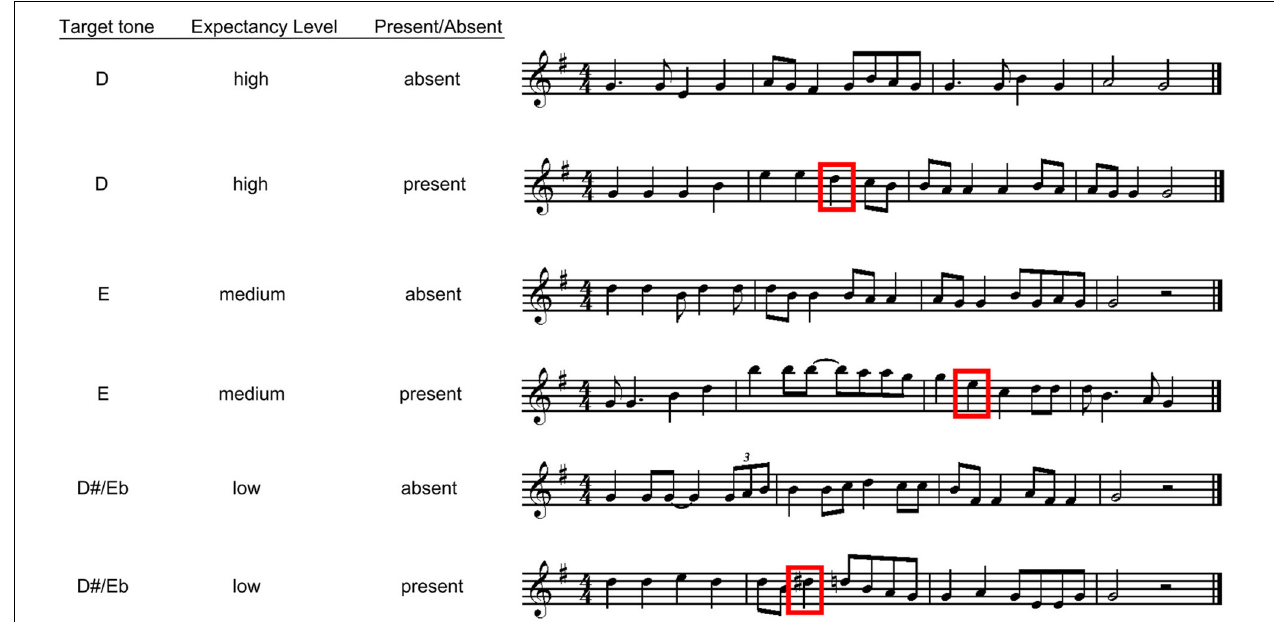
FIGURE 1 | Examples of experimental stimuli for Experiment 1. The boxes indicate present